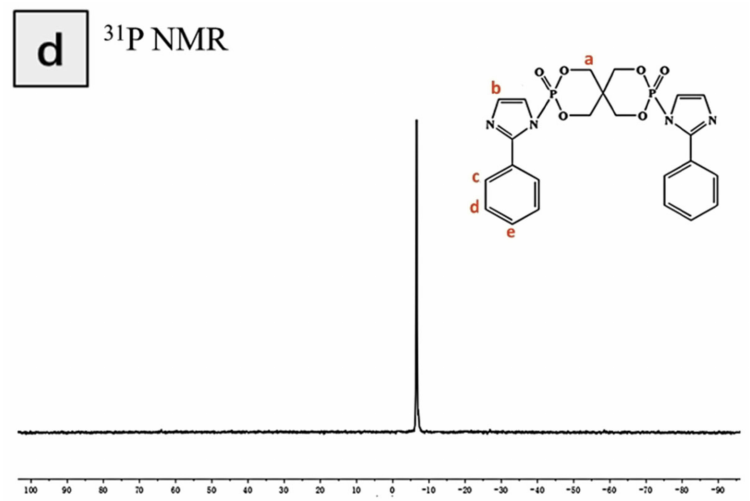
Figure 2. 1 H NMR ( a ) and 31 P NMR ( b ) spectra of SPDPC; 1 H NMR ( c ) and 31 P NMR ( d ) spectra of PIPC.